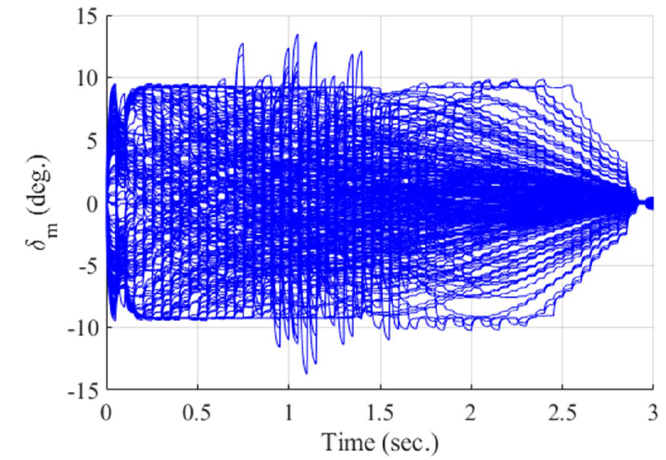
Figure 13. Control input of the missile (Monte Carlo simulation).